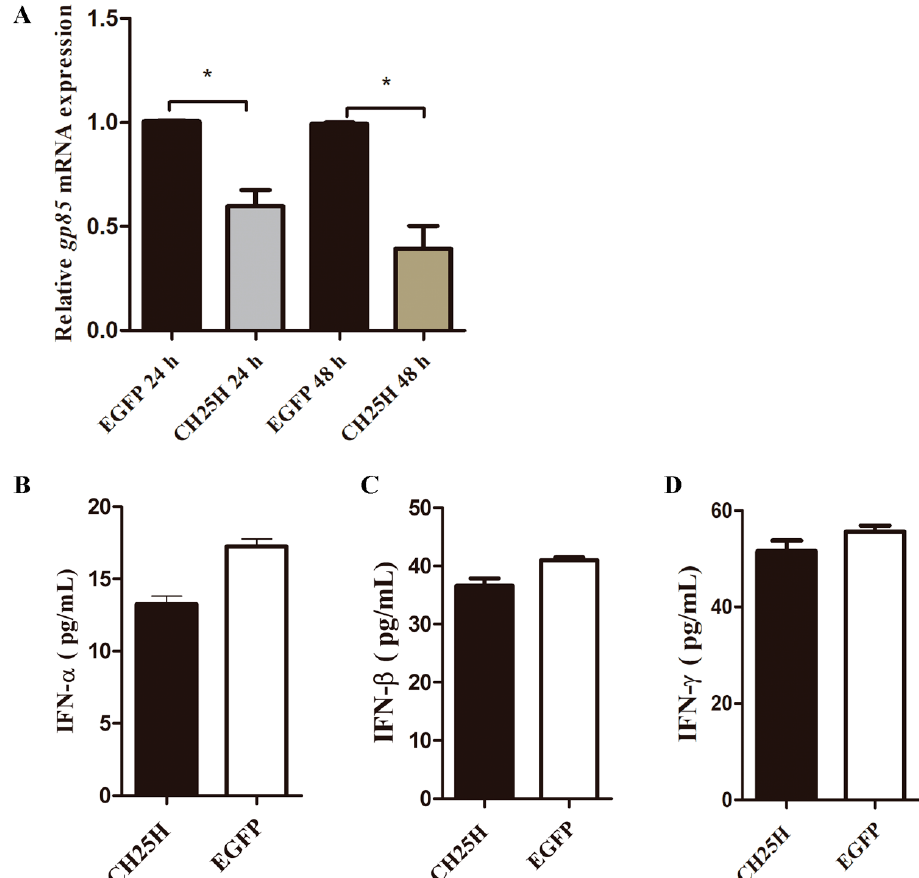
Figure 7. chCH25H produces a soluble anti-ALV-J factor that is not chicken type I and II IFN. ( A ) DF1 cells were pretreated with the cell supernatants collected from DF1 cells overexpressing chCH25H at 24 h post transfection. Compared to the cell supernatants collected from DF1 cells overexpressing EGFP , cell supernatants collected from DF1 cells overexpressing chCH25H could significantly inhibit the expression of ALV-J gp85 gene at 24 and 48 hpi. ( B – D ) chIFN including IFN- α , IFN- β and IFN- γ were detected by ELISA in the cell supernatants collected from DF1 cells overexpressing chCH25H . Compared to control, no chIFN were significantly induced by overexpressing chCH25H . * p < 0.05. 3.8. 25HC, the Product of chCH25H, Has Anti-ALV-J Activity CH25H catalyzes oxidation of cholesterol to 25HC (Figure 8A), a soluble oxysterol that acts as an antiviral factor to broadly inhibit the growth of enveloped viruses such as vesicular stomatitis virus (VSV), ebola virus (EBOV) and human immunodeficiency virus (HIV) [8]. The treatment of DF1 cells with different concentrations of 25HC for 24 h showed that 1 μ M of 25HC is the highest concentration that is not toxic to cells (Figure 8B). The results of qPCR and p27 ELISA showed that the treatment of normal DF1 cells and chCH25H knockout DF1 cells with 1 μ M of 25HC significantly inhibited the expression of ALV-J gp85 mRNA and p27 protein at 24 and 48 hpi (Figure 8C–F). All of these results suggested that 25HC, a product of CH25H , could inhibt ALV-J replication in DF1 cells.